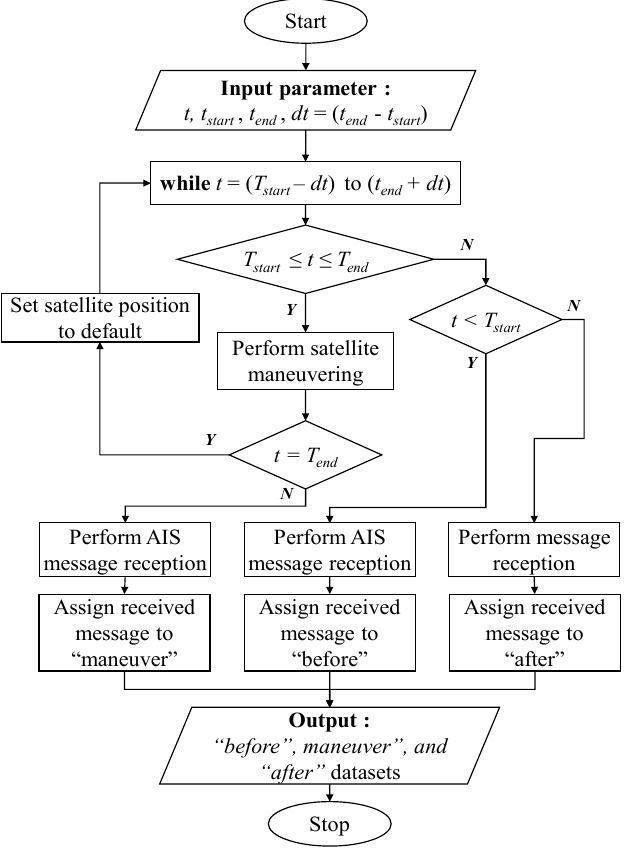
Figure 6. A complete step for providing the necessary dataset used to assess the impact of satellite maneuvering to message reception performance.